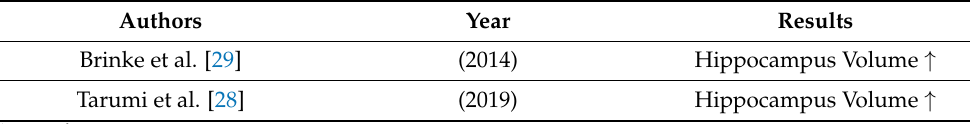
Table 3. The overall results of the brain structures in reviewed studies.